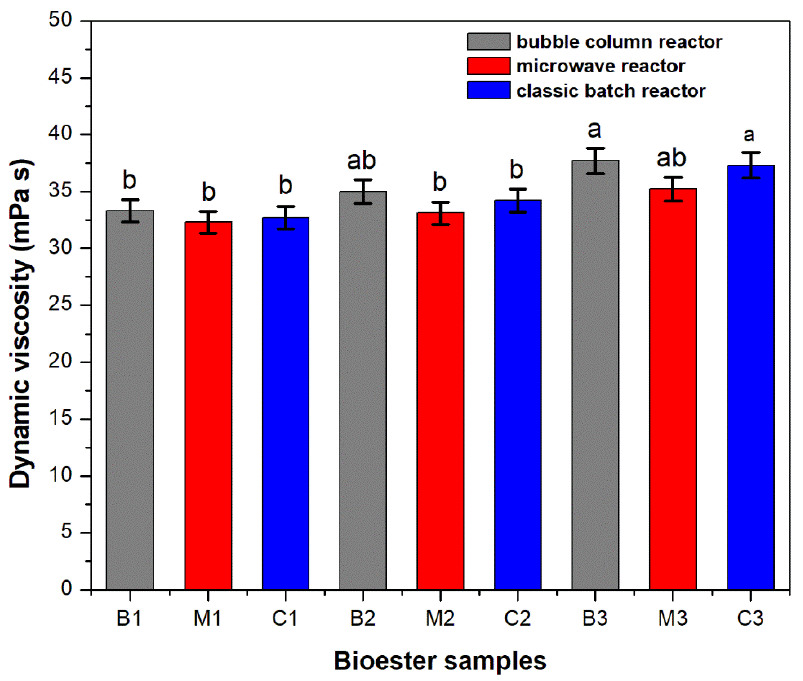
Figure 1. Dynamic viscosity at 25 °C, for the synthetized bioesters. Values are expressed as means of three independent replicates and error bars represent the standard deviation. Columns denoted by different letters indicated significant ( p < 0.05) differences among different synthesis conditions.